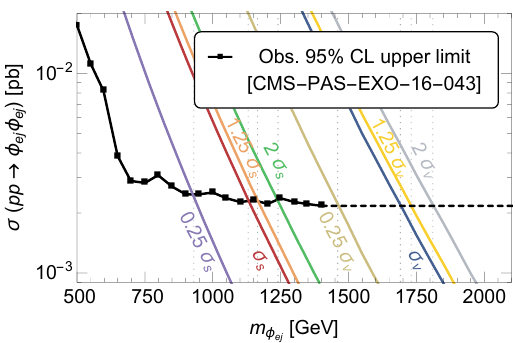
Figure 11 . Bounds on scalar and vector leptoquarks that decay into ( ej )( ej ) (cid:12)nal states. The observed 95% CL upper limit on the production cross section (black solid line) is taken from a search for leptoquarks in the ( ej )( ej ) (cid:12)nal state by CMS [52] which stopped at 1.4 TeV. See the caption of (cid:12)gure 8 for